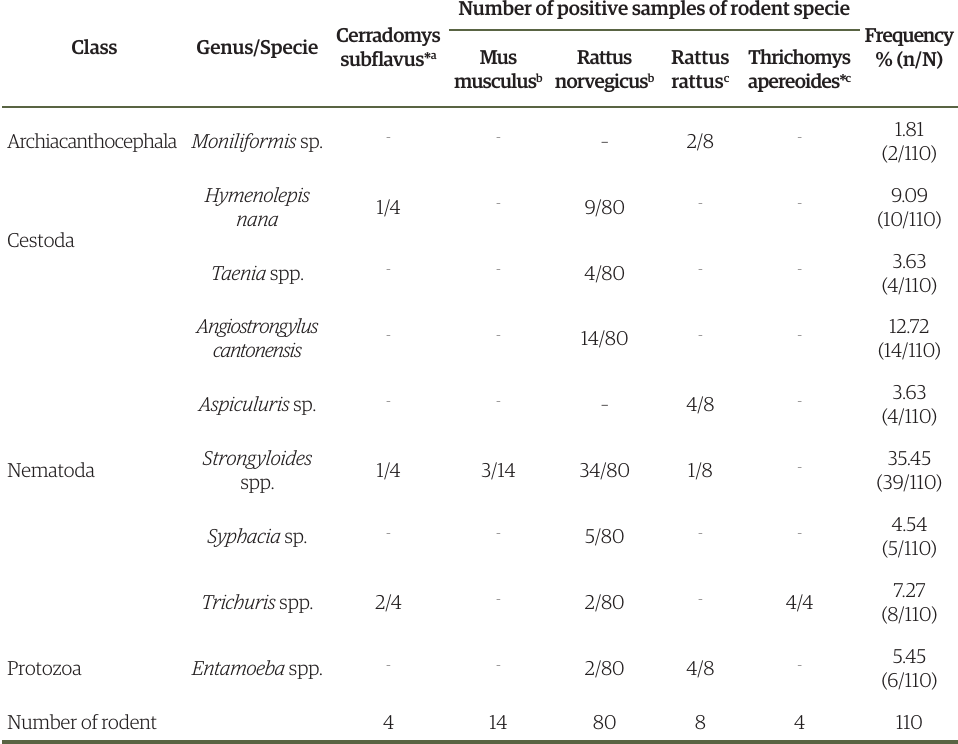
Number of positive samples of rodent specie Cerradomys Frequency Rattus Rattus Thrichomys subflavus* a % (n/N)Mus musculus b norvegicus b rattus c apereoides* c